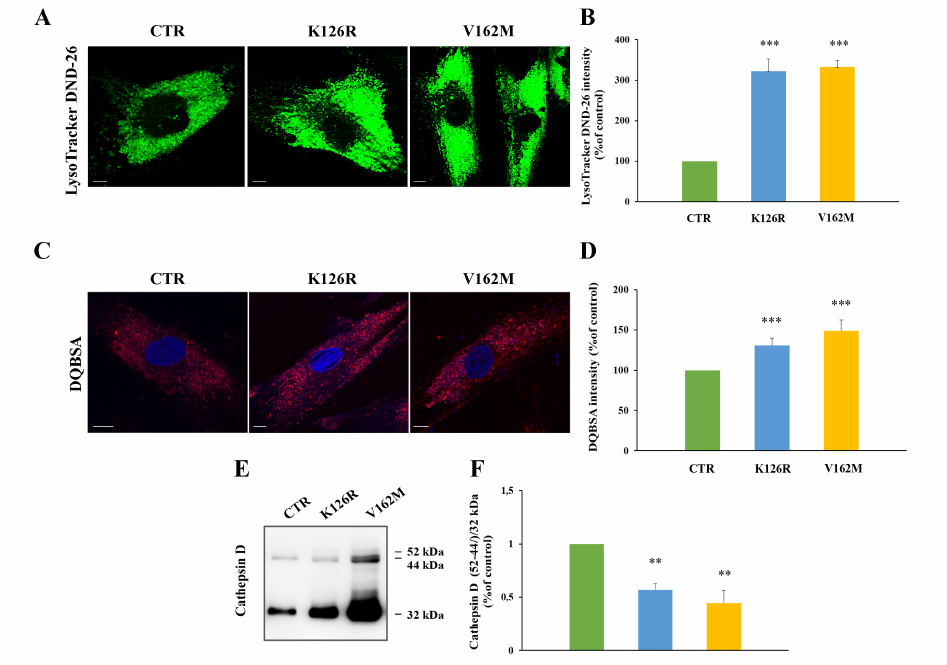
Figure 5. Alterations of late endocytic compartments in K126R mutated fibroblasts. ( A ) Cells were labeled with LysoTracker DND-26 (green) and ( B ) fluorescence intensity was quantified by ImageJ software. ( C ) Cells were incubated in the presence of DQ-Red BSA and ( D ) fluorescence intensity analyzed by ImageJ software. Nuclei were labeled with DAPI (blue). Scale bars = 10 µ m. ( E ) Relative abundance of the three Cathepsin D forms was assessed by Western blotting and ( F ) quantified by densitometry normalizing against the 32 kDa mature form. Values are the mean ± SE of three different and independent experiments. ** p < 0.01; *** p <